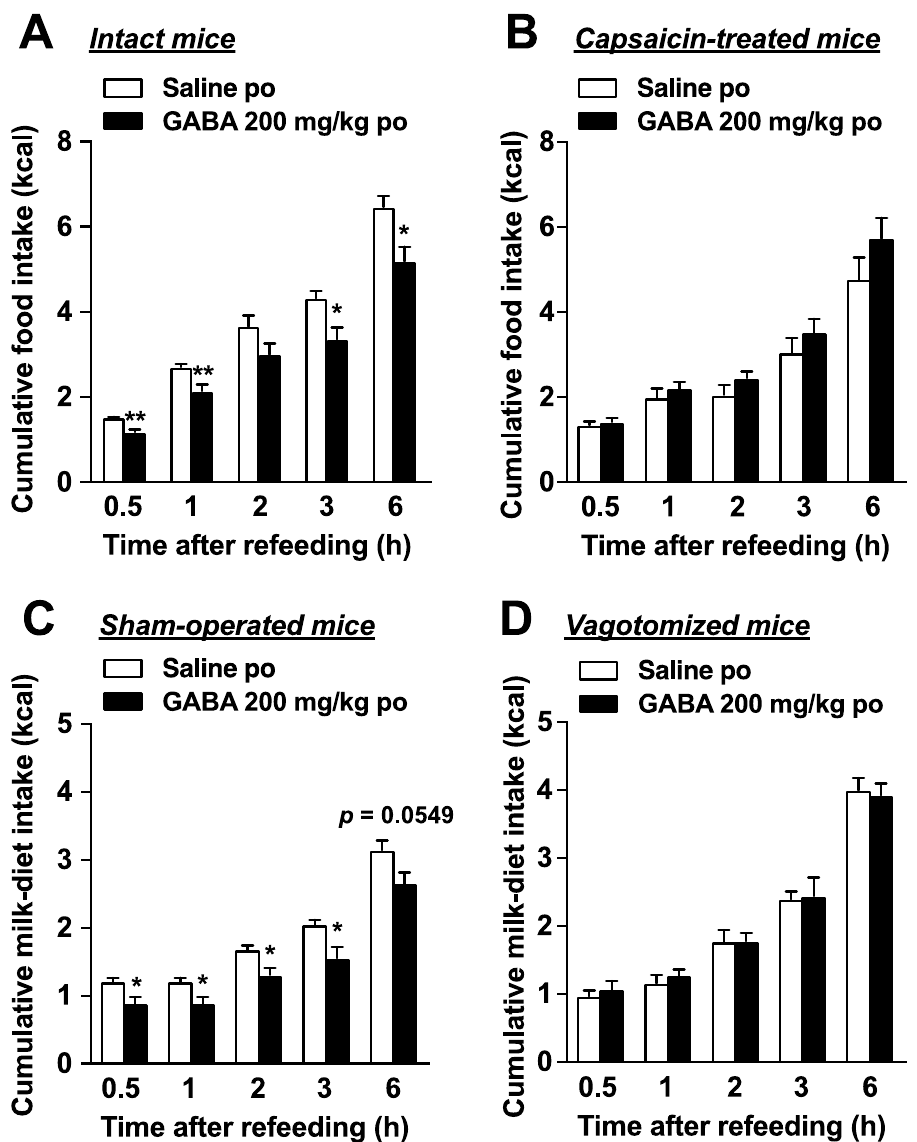
Figure 3. Peroral GABA administration suppresses food intake via vagal afferents. ( A ): Peroral administration of GABA (200 mg/kg) immediately before refeeding significantly reduced food intake in intact mice fasted overnight (16 h). n = 6. ( B ): The feeding suppression by po GABA administration (200 mg/kg) immediately before refeeding was abolished in mice whose sensory nerves including vagal afferent nerves were denervated by systemic treatment with capsaicin. n = 6. ( C , D ): GABA (200 mg/kg, po) reduced cumulative milk-diet intake in sham-operated ( C ) but not subdiaphragmatic vagotomized mice ( D ). n = 5–8. * p < 0.05, ** p < 0.01 by unpaired t -test. po, peroral. GABA: Gamma-aminobutyric